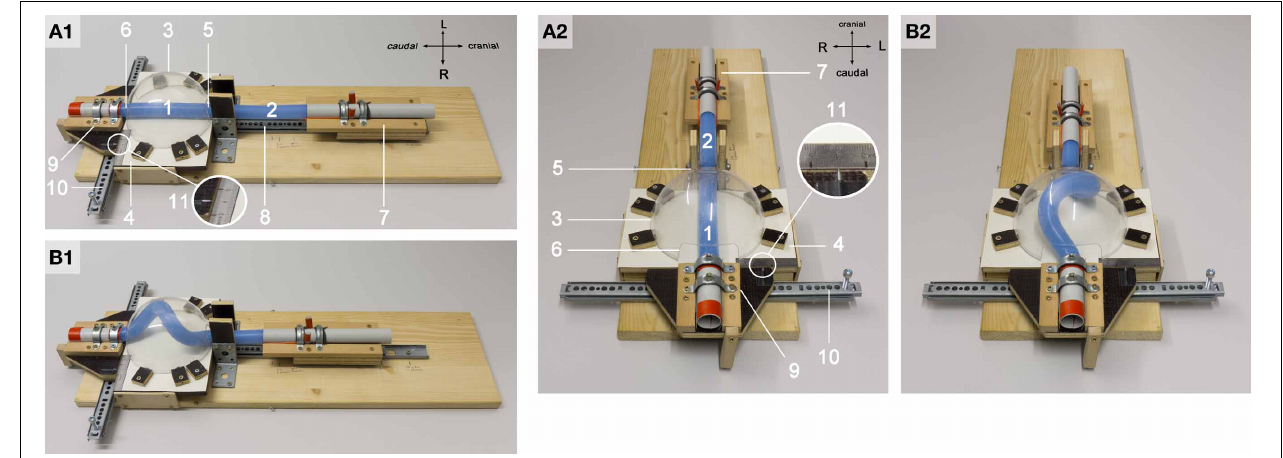
FIGURE 4 | These photographs document the design of our physical simulation model. The model is shown in two different views before (A1,A2) and during a buckling experiment (B1,B2) . Numbers mark the following components: 1, “intra-pericardial” portion of the silicone rod; 2, “extra-pericardial” portion of the silicone rod; 3, hemispherical plastic bowl representing the ventro-lateral walls of the “pericardial” cavity; 4, plane stage representing the dorsal wall of the “pericardial” cavity; 5, opening at the “cranial (arterial)” pole of the “pericardial” cavity; 6, opening at the “caudal (venous)” pole of the “pericardial” cavity; 7, “cranial” sledge